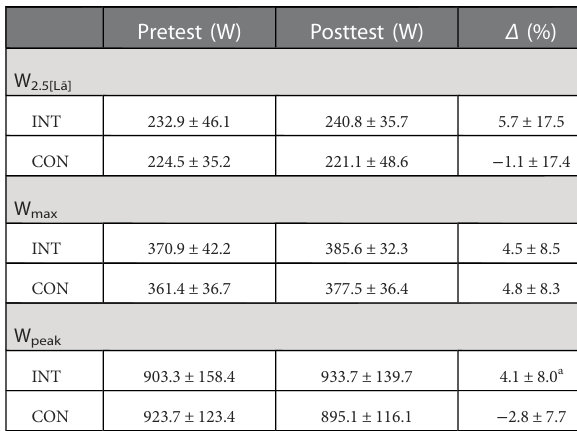
TABLE 1 Performance indicators before (pretest) and after (posttest) a 12-week period of training. In addition, relative changes ( Δ ) from pretest to posttest are included. Values are presented as